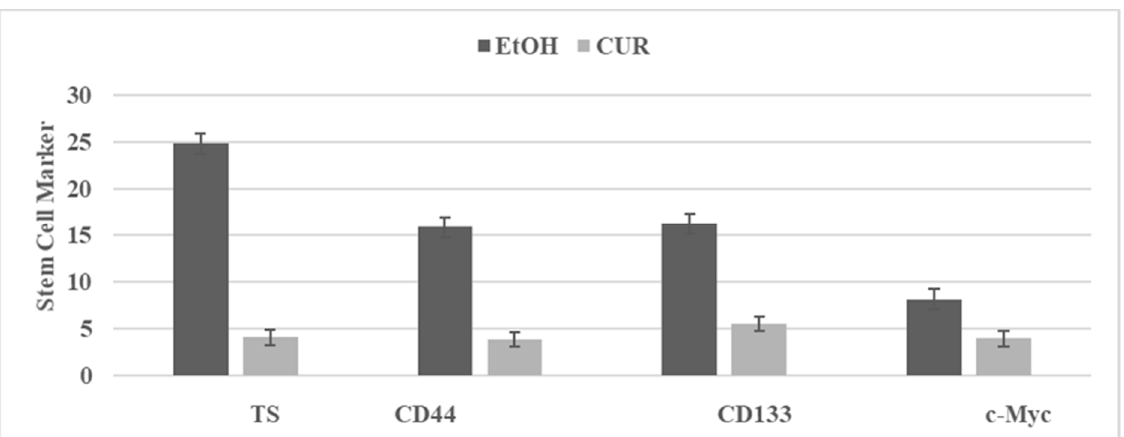
Figure 4. Effect of curcumin on stem cell markers in SU-R 850 MIN COL phenotype. TS: Tumor spheroid number determined at day 14 after seeding of 100 cells. Mean ± SD, n = 3 per treatment group. CD44, CD133, c-Myc. RFU determined at day four after seeding 1.0 × 10 5 cells. EtOH, ethanol; CUR, curcumin; CD, cluster of differentiation; c-Myc, cellular Myc; RFU, relative fluorescent unit.